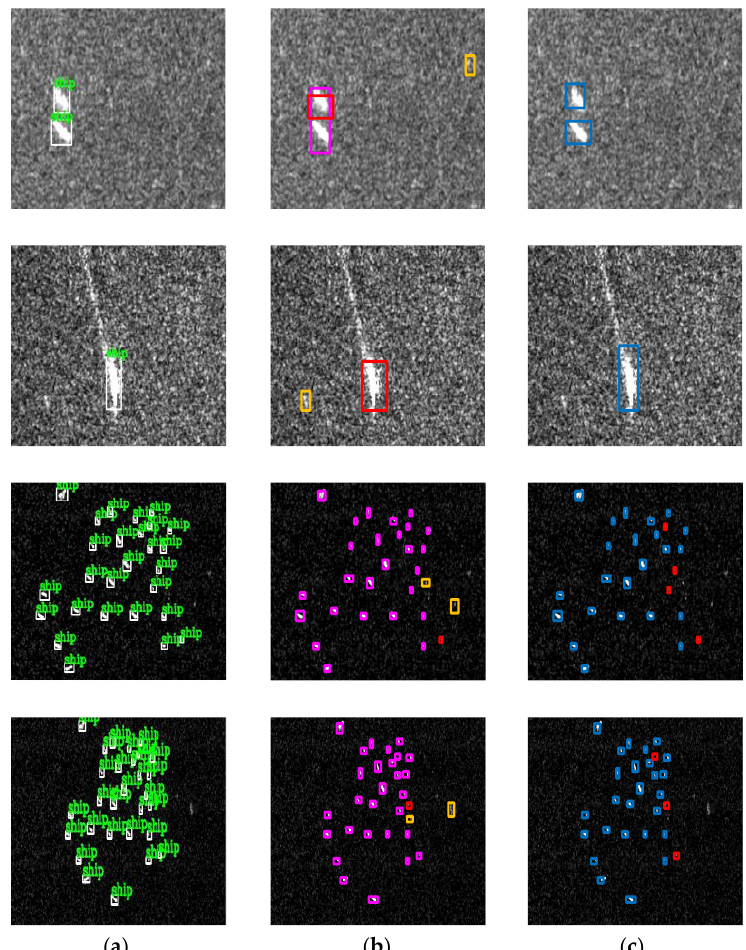
Figure 18. The effect of a pre-processing refined lee filter on high noise samples and small ship samples. ( a ) Ground truth; ( b ) G-CNN without refined lee filter; ( c ) G-CNN with refined lee filter. The miss-detection is marked in red and the false alarm is marked in yellow.